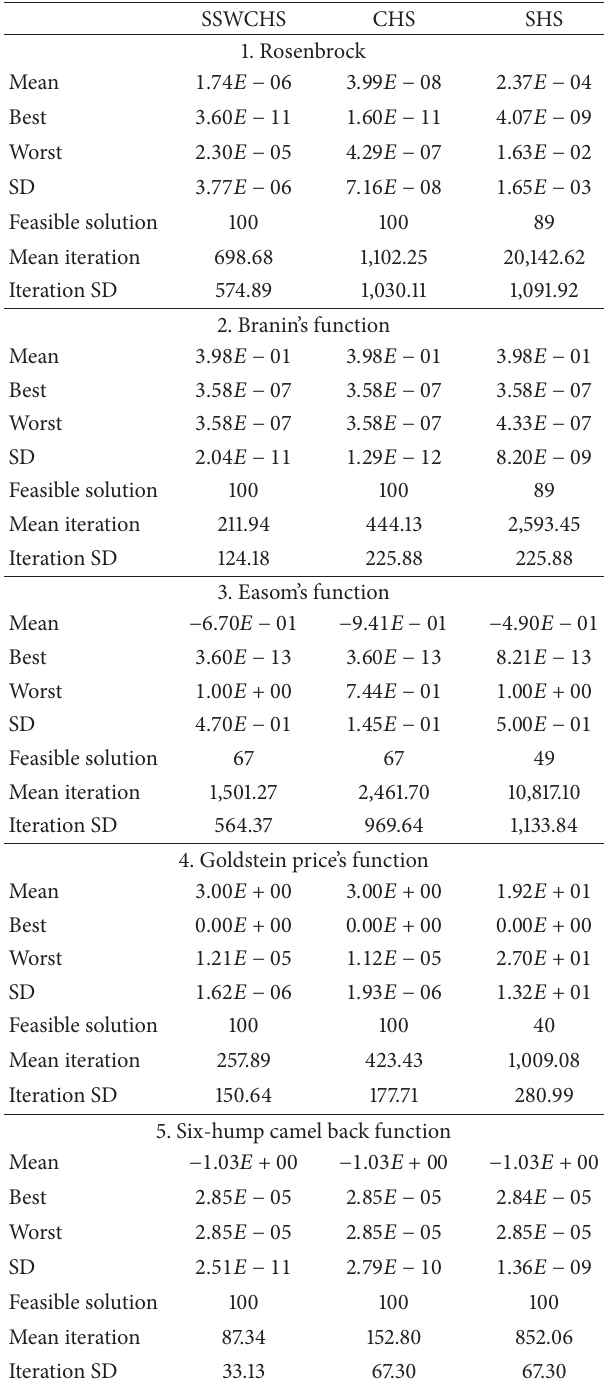
Table 3: Obtained statistical results of 2D benchmark